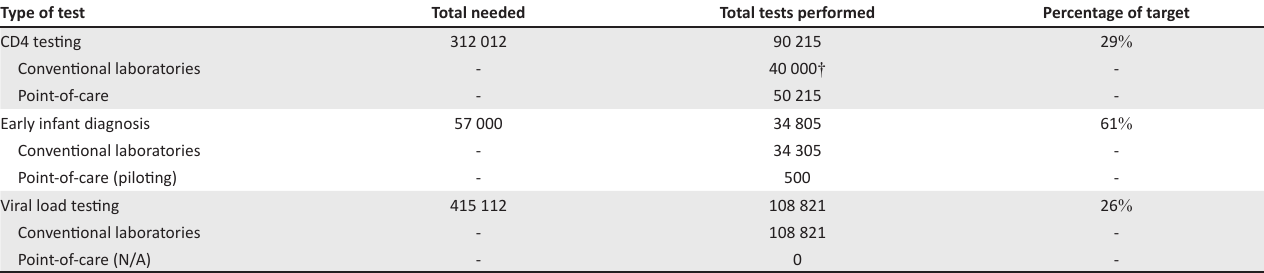
TABLE 3: Summary of CD4, early infant diagnosis, and viral load testing in